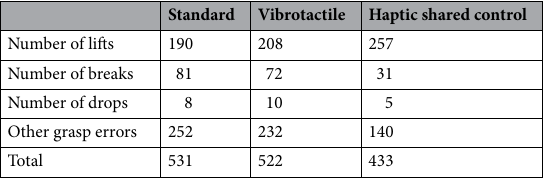
Table 1. Number of grasp errors.